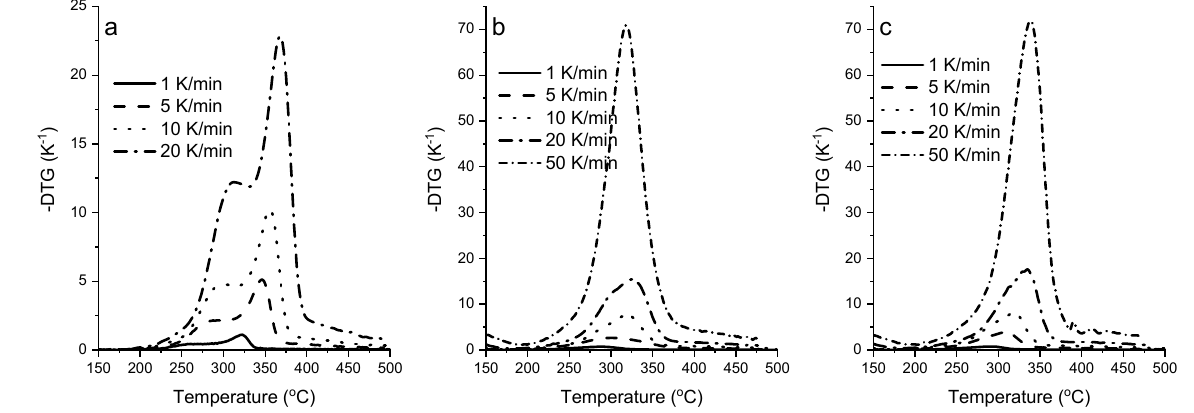
Figure 2. Comparison of the DTG behavior divided by feedstock: ( a ) beech; ( b ) WS-P; and ( c ) WS-H.